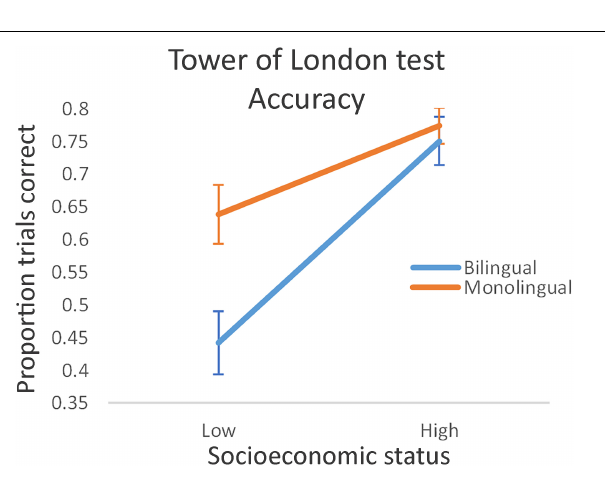
FIGURE 2 | Tower of London test accuracy: proportion of trials correctly completed by low and high socioeconomic status bilinguals and monolinguals. Bars show standard